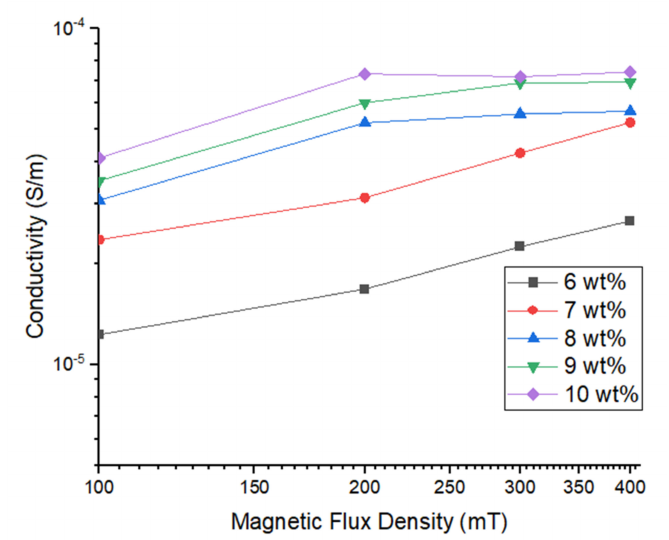
Figure 9. Conductivity of all samples with various Gr contents under different magnetic flux densities.